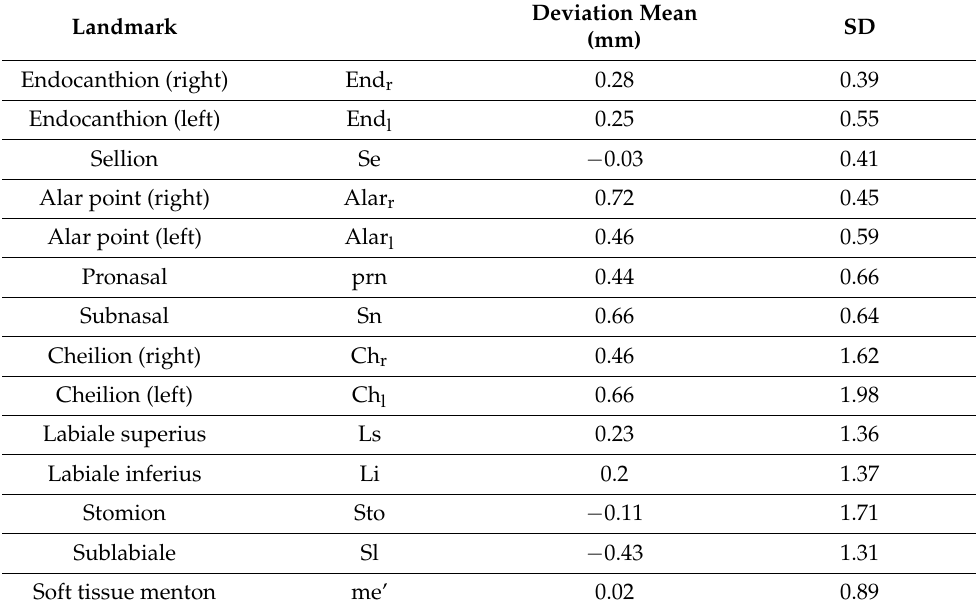
Table 6. Deviation analysis of the facial soft tissue landmarks. Landmark